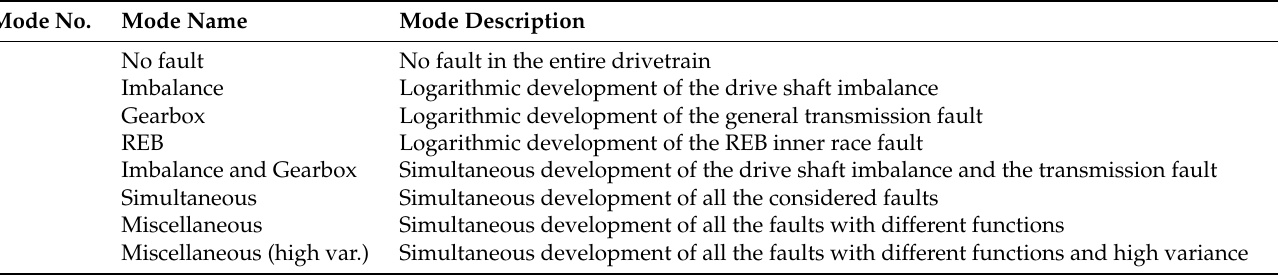
Table 1. Failures modes of generated